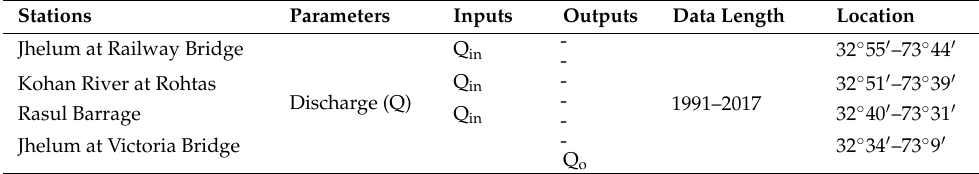
Table 1. Description of the